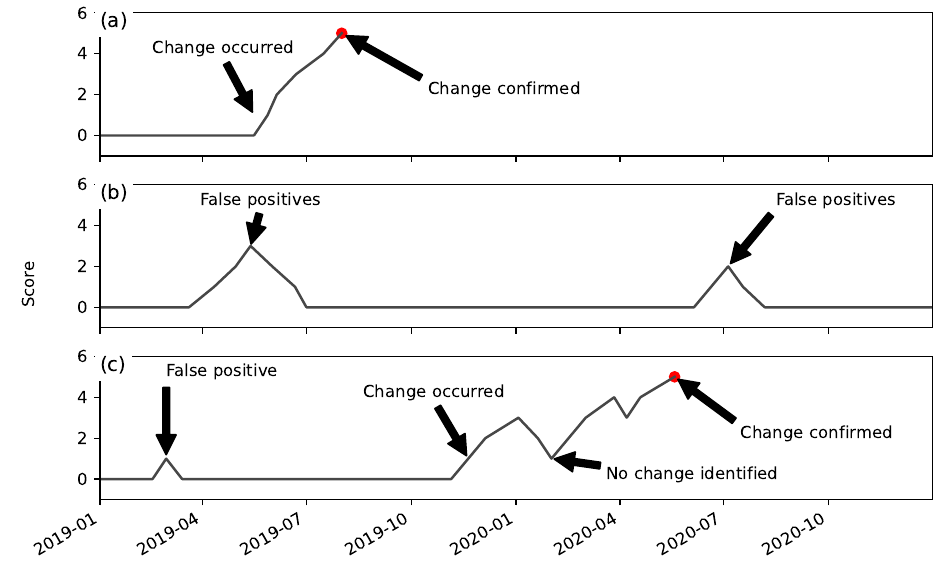
Figure 5. Examples for individual pixels illustrating the scoring system. Examples: ( a ) a change occurring, ( b ) false positives (e.g., misclassified clouds) ignored by the scoring system, and ( c ) a more complex example of a change occurring with a false positive and some observations which have missed identified the